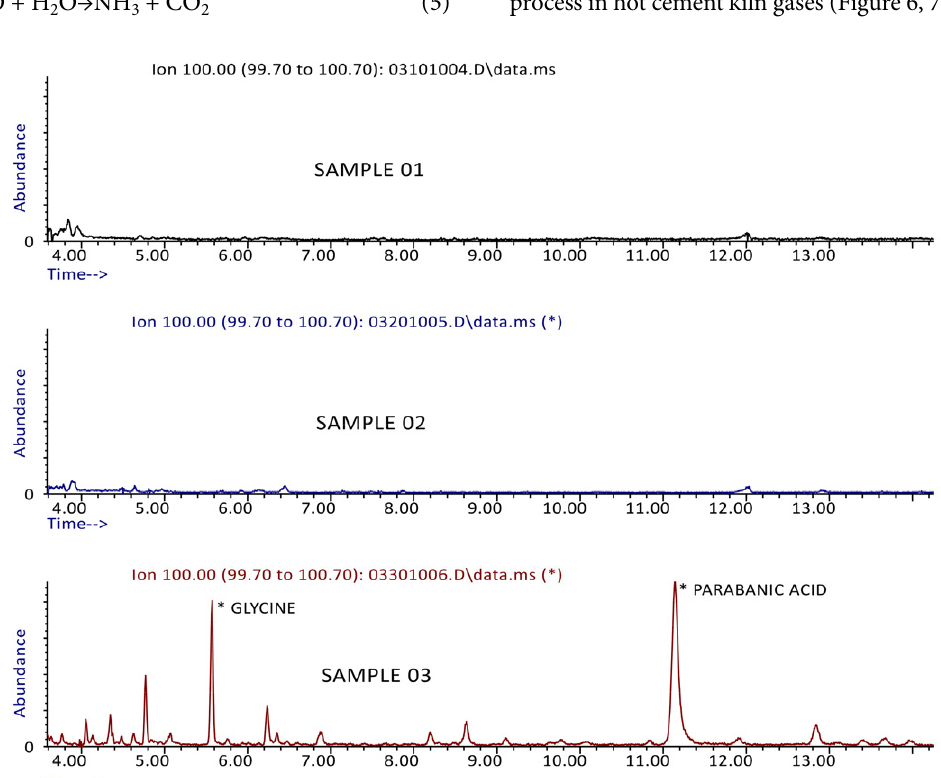
Figure 9. Comparison of ion current of mass fragments m/z 100 characteristic for silylated derivatives of glycine and parabanic acid TMS derivative from all three sample